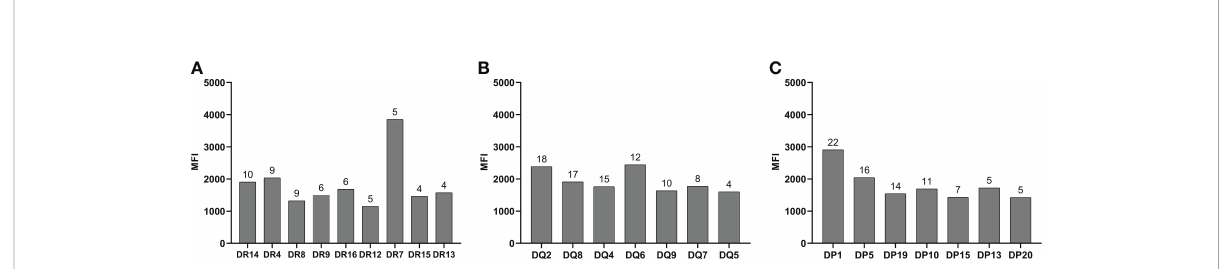
FIGURE 2 Type of HLA-DR, DQ, and DP speci fi c antibodies. (A) DR antibody speci fi city type. (B) DQ antibody speci fi city type. (C) DR antibody speci fi city type. The numbers on the bars represent the number of patients positive for the speci fi c